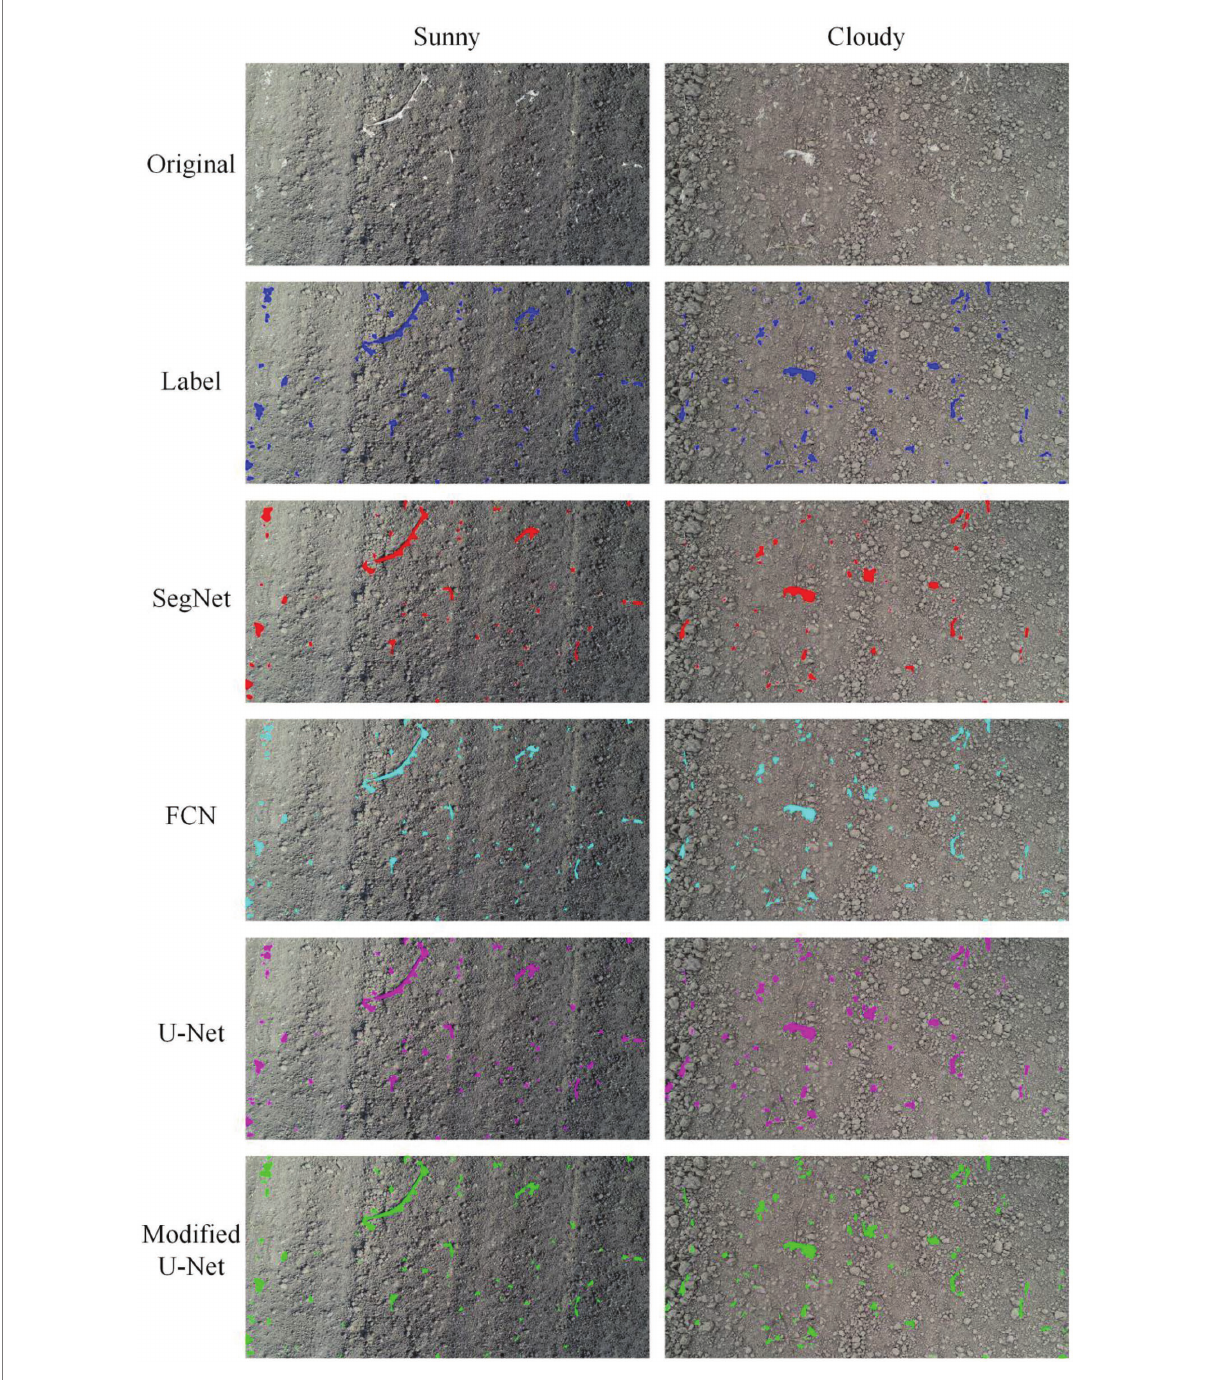
FIGURE 6 Residual film segmentation results under different weather